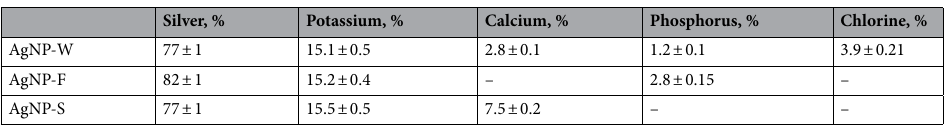
Table 2. Elemental composition of the synthesized silver nanoparticles by Carduus cripus.